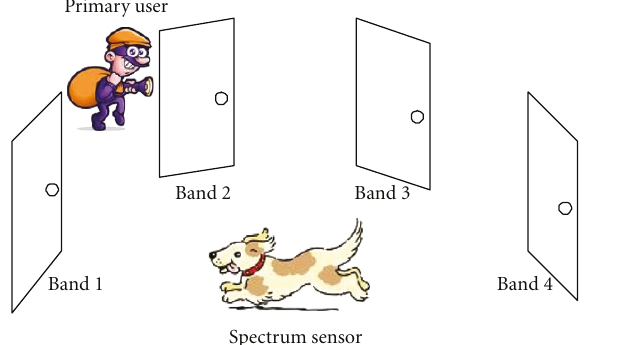
Figure 1: Illustrating spectrum sensing over multiple frequency channels.